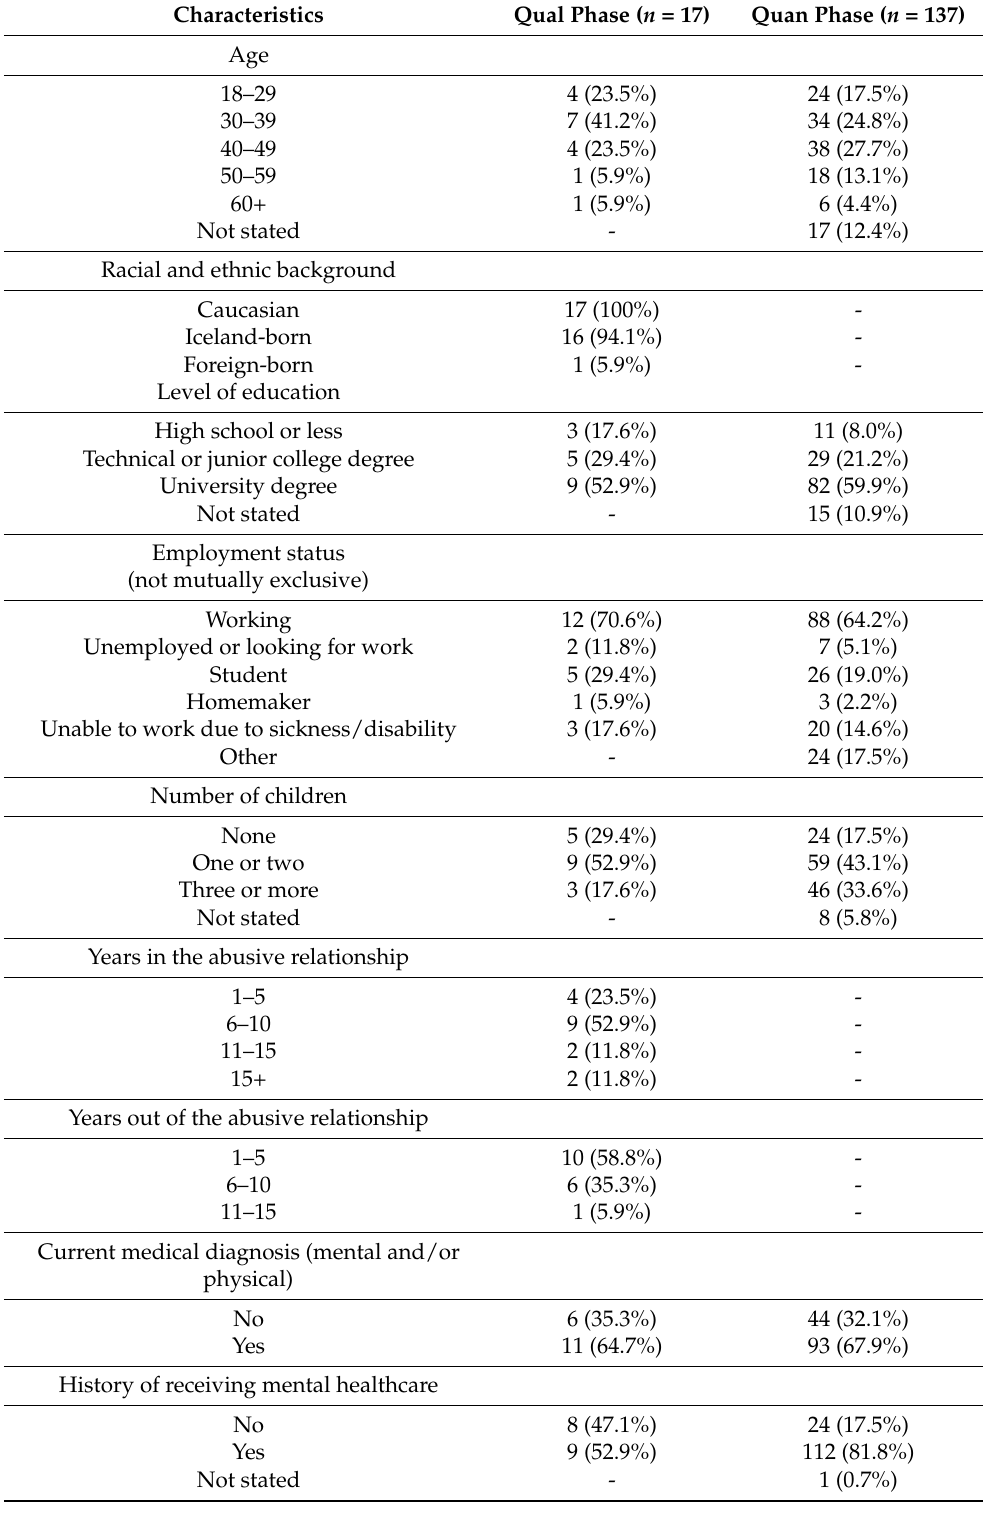
Table 1. Characteristics of participants in both